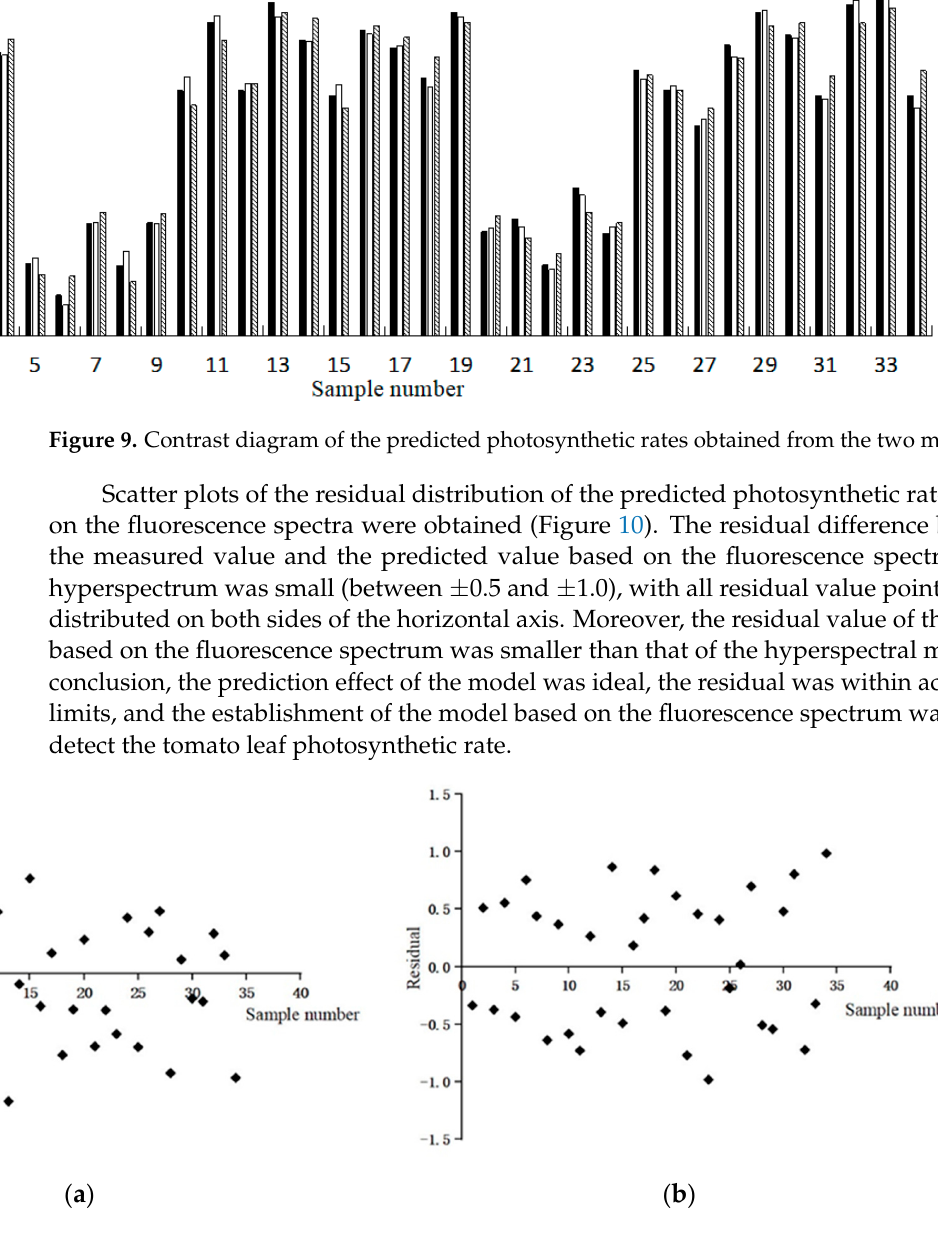
Figure 8. ( a ) Scatter plot of measured and predicted photosynthetic rates based on fluorescence spectral model l; ( b ) scatter plot of measured and predicted photosynthetic rates based on hyper- spectral model.